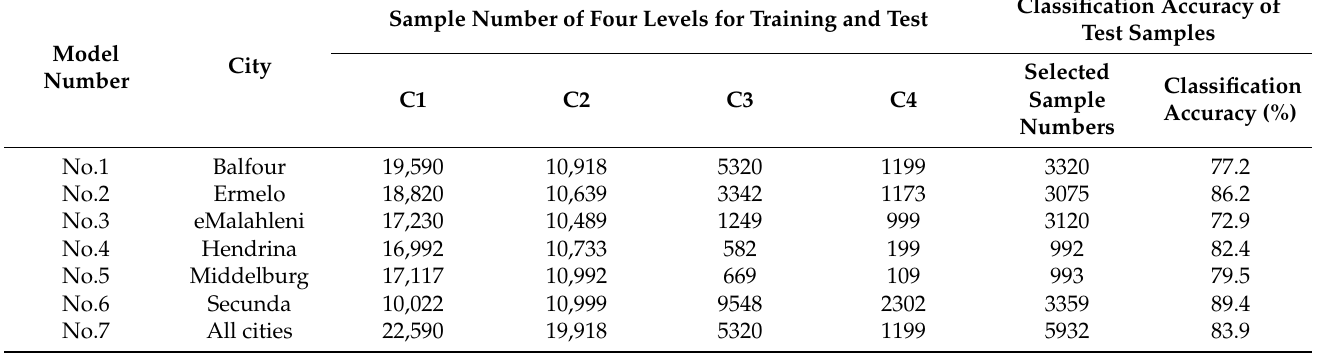
Table 2. The BP classifier training model for six cities in Mpumalanga province near Secunda, and the trained classifier’s classification accuracy for the test